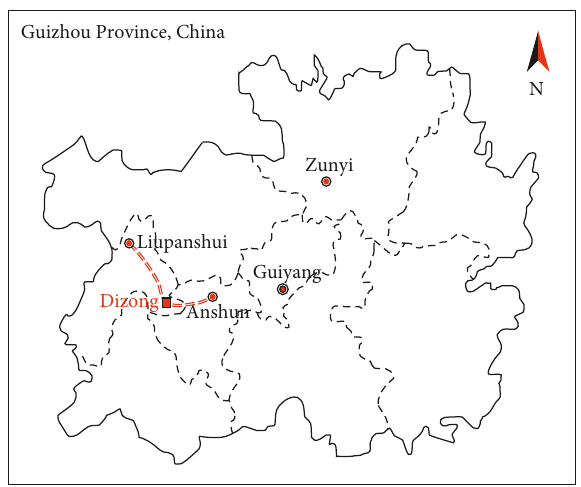
Figure 1: Schematic diagram of the location of the Dizong tunnel.